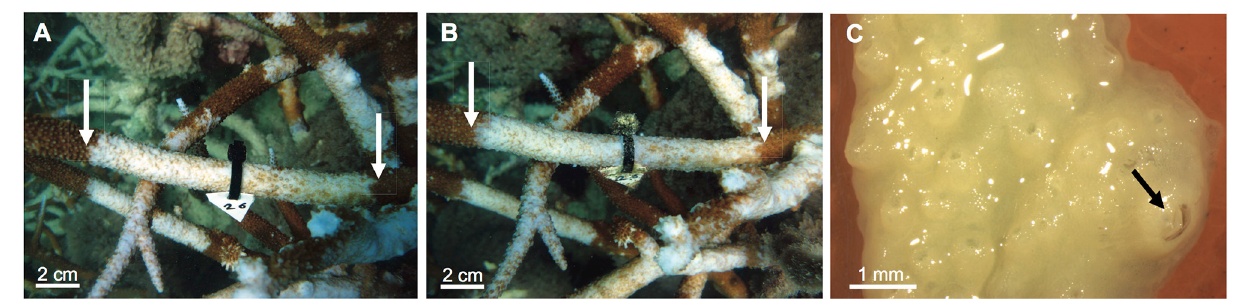
FIGURE 1 | Field photographs to quantify the progression rate of a tagged plaque-like growth anomaly on a colony of Acropora muricata between (A) September 2010 and (B) October 2010. White arrows denote the linear extent of the growth anomaly lesion. (C) Microscopic image of decalcified tissues of A. muricata showing the presence of a barnacle causing further tissue deformation (arrow) within a growth anomaly.